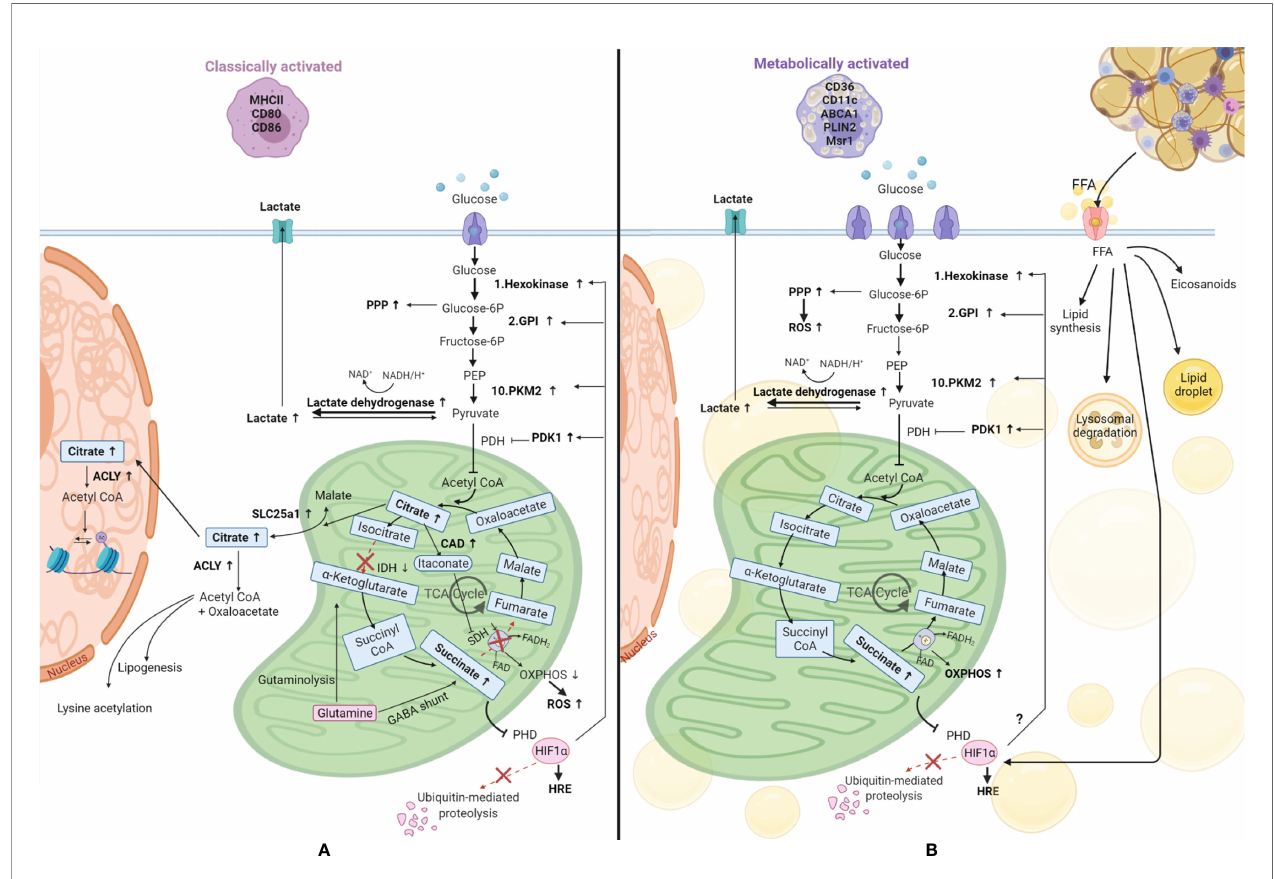
FIGURE 4 | Comparison of metabolic reprogramming of classically and metabolically activated macrophages. (A) Classically activated macrophages and their metabolism. (B) Metabolically activated macrophages and their metabolism. Adipose tissue macrophages in obesity internalize free fatty acids (FFA) and lipids from the dying adipocytes, becoming foam cells. These FFA can be used to synthesize new lipids, can be stored in lipid droplets, can be catabolized through the lysosomal pathway or be used to produce in fl ammatory lipid mediators called eicosanoids. Glucose is the main source of energy also in metabolically activated macrophages, where the glucose transporter is overexpressed, and it is catabolized by glycolysis, which is upregulated, providing substrates for the pentose phosphate pathway (PPP), also upregulated. Also the metabolic pathway OXPHOS (oxidative phosphorylation) is upregulated in these cells, underlying their high energy demand. Succinate production is increased in these cells. This metabolite inhibits prolyl hydroxylase domain (PHD) proteins, resulting in less hydroxylation of hypoxia-inducible factor 1-alpha (HIF-1 a ), which circumvents its degradation, allowing its binding to hypoxia response elements (HRE) on target genes (48). HIF-1 a is also promoted by FFA and we hypothesize it might promote the switch to glycolysis by inducing glycolytic enzymes as it happens in classically activated macrophages. TCA, tricarboxylic acid cycle; SLC25a1, solute carrier family 25 member 1; ACLY, ATP citrate lyase; IDH, isocitrate dehydrogenase; SDH, succinate dehydrogenase; CAD, cis-aconitate decarboxylase; GABA, g -aminobutyric acid; PHD, prolyl hydroxylase domain; ROS, reactive oxygen species; PKM2, pyruvate kinase M2; GPI, glucose-6-phosphate isomerase; PEP, Phosphoenolpyruvate; PDH, Pyruvate dehydrogenase; PDK1, pyruvate dehydrogenase kinase 1; FAO, fatty acid